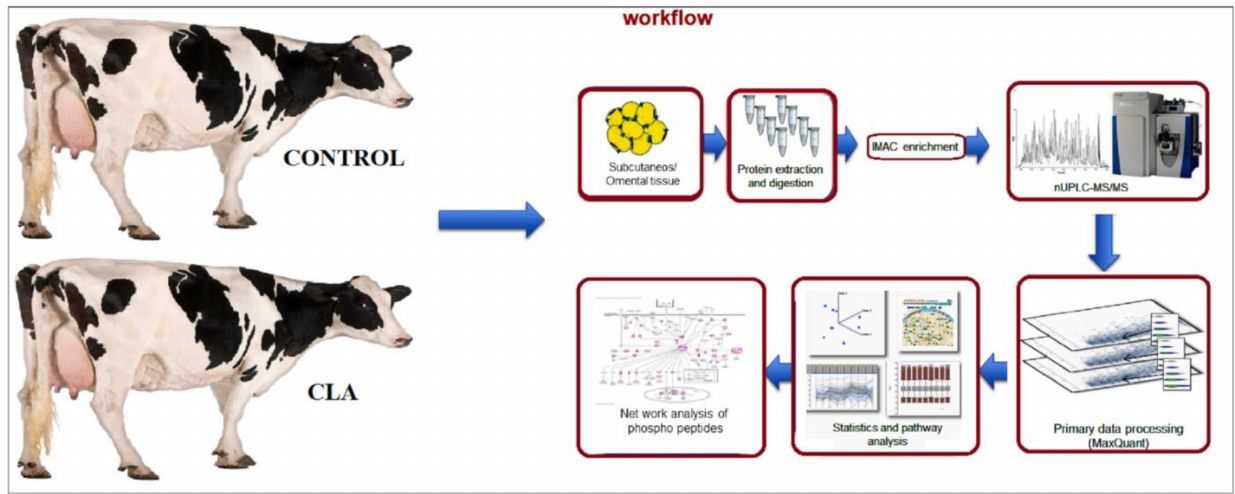
Figure 1. Workflow diagram of phosphoproteomic analysis by NanoUPLC-MS/MS of subcutaneous and omental AT from CLA-supplemented and control dairy cows. The subcutaneous ( n = 10) and omental ( n = 10) AT samples from 5 control and 5 CLA-supplemented cows were collected and protein was isolated. The extracted proteins were digested and the peptides were sequenced using nanoUPLC/MS/MS and phosphoprotome analysis. The primary data was quantified in Maxquant software and statistical values were corrected for pathway analysis. Network analysis was conducted using the cytoscape software related to lipid turnover. We detected a total of 5919 PP in AT at a 1 percent false localization rate (FLR). The abundance of 854 PP (14.4%) was different between CLA and CON ( p ≤ 0.05, fold change (FC) ± 1.5) (Supplementary Data Sheet S1). The abundance of 470 PP (7.9%) differed between OM and SC AT ( p ≤ 0.05, FC ± 1.5), and the interaction treatment vs. AT depot was significant for 205 PP (3.5% of total PP). From the 854 differential PP in CLA vs. CON, only 73 PP had a significant interaction of treatment vs. AT depot (8.5%; Supplementary Data Sheet S1). As the main effect observed was the difference between CLA and CON AT, we will first elaborate on these differential